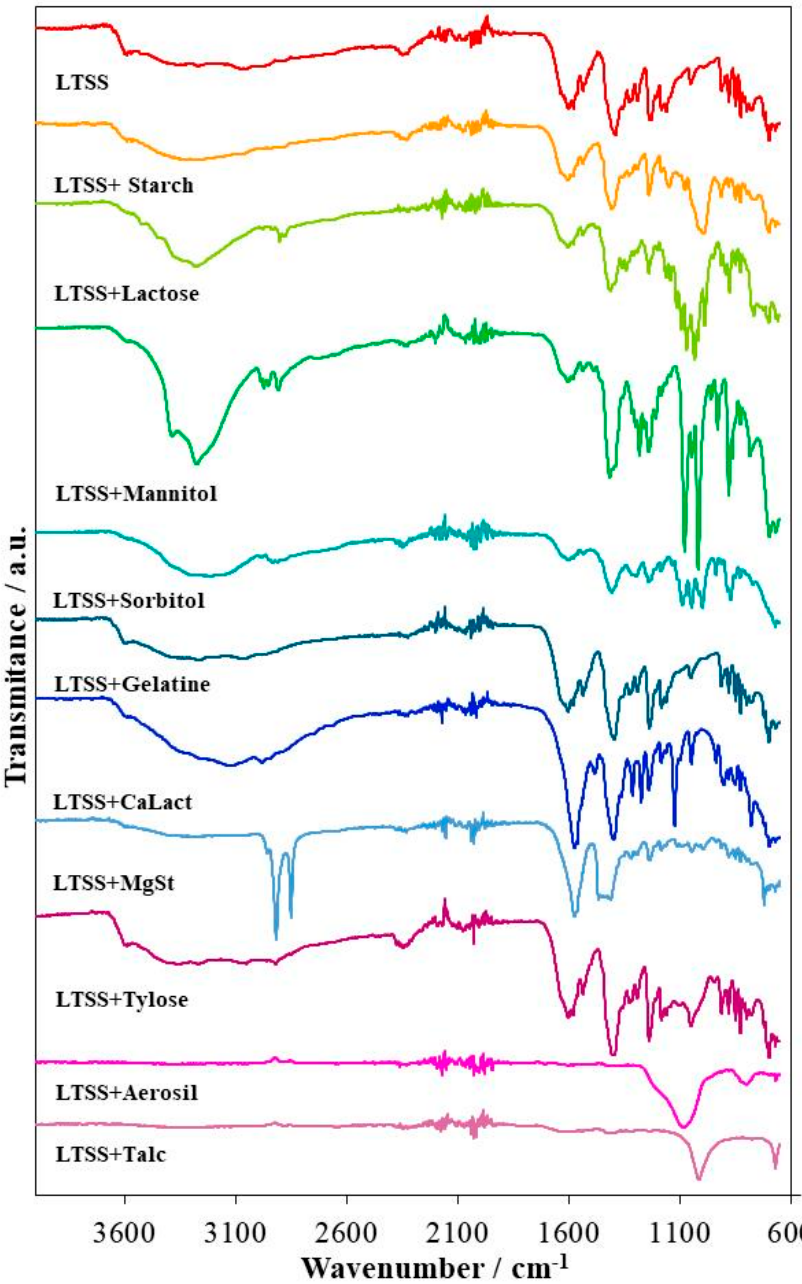
Figure 2. Universal attenuated total reflectance-Fourier transform infrared spectroscopy (UATR-FTIR) spectra of LTSS and binary mixtures with excipients.